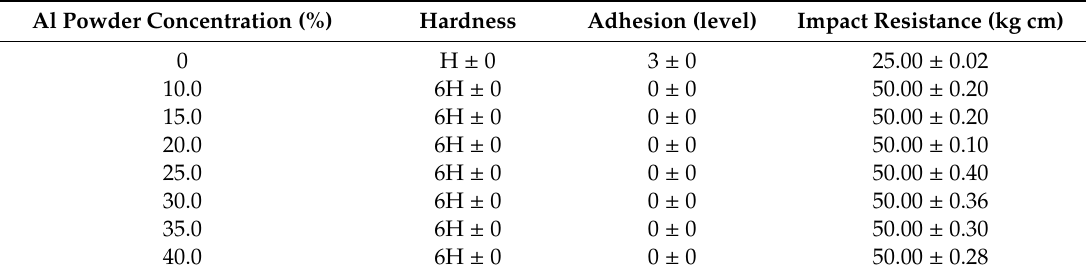
Table 6. E ff ect of the Al powder concentration on hardness, adhesion and impact resistance. Al Powder Concentration